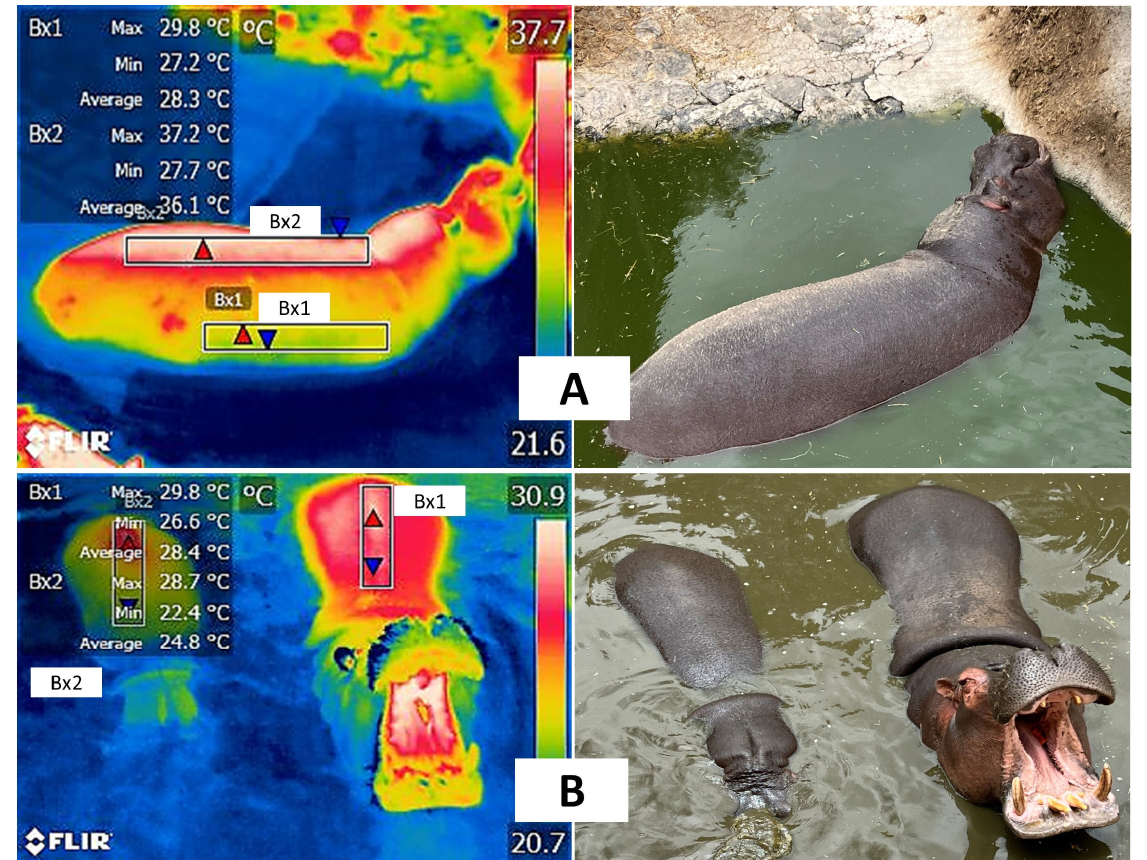
Figure 9. Importance of ponds or pools to improve the comfort level of hippopotami housed in zoos. ( A ). Dorsal and lateral body window with total immersion in a pond. A difference of 7.8 ◦ C can be seen between the mean temperatures of the lateral (Bx1) and dorsal regions (Bx2). This is due to the effect of solar radiation that falls directly on the dorsal region, which, in contact with the lateral region with the water, can dissipate heat more efficiently and maintain lower temperatures. ( B ). Effect of immersion in water on the thermoregulation of a mother and her calf. A decrease of 3.6 ◦ C is observed in the mean temperature in the offspring’s dorsal region (Bx2) in contrast to that of the mother (Bx1). This temperature drop is associated with the fact that the calf’s skin was moist when the image was taken. Both cases reflect the importance of ponds or pools to help maintain thermoneutrality in animals with poor thermoregulation mechanisms, like the hippopotamus ( Hippopotamus amphibius ). (Radiometric images and photographs by the